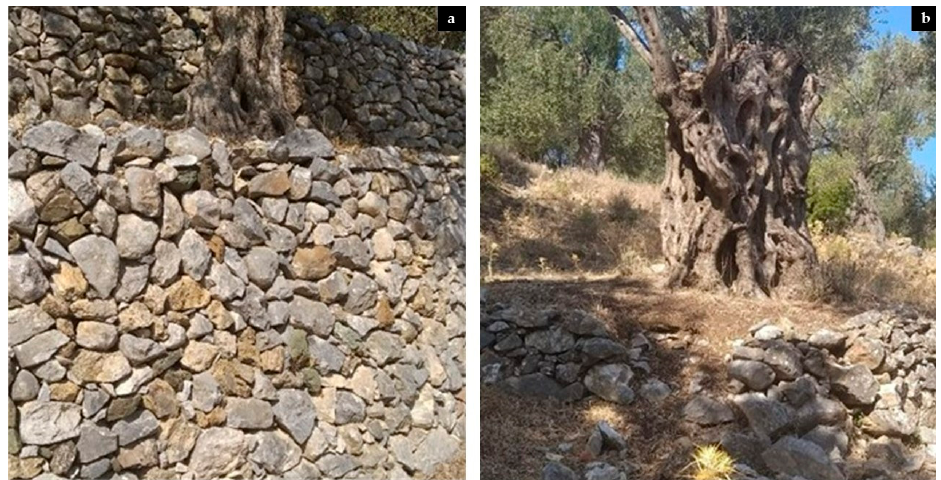
Figure 1. On the left ( a ) the highly maintained drystone terrace sound recording spot in the Thermi area, and on the right ( b ) the poorly maintained drystone terrace sound recording spot in the Pamfila area.